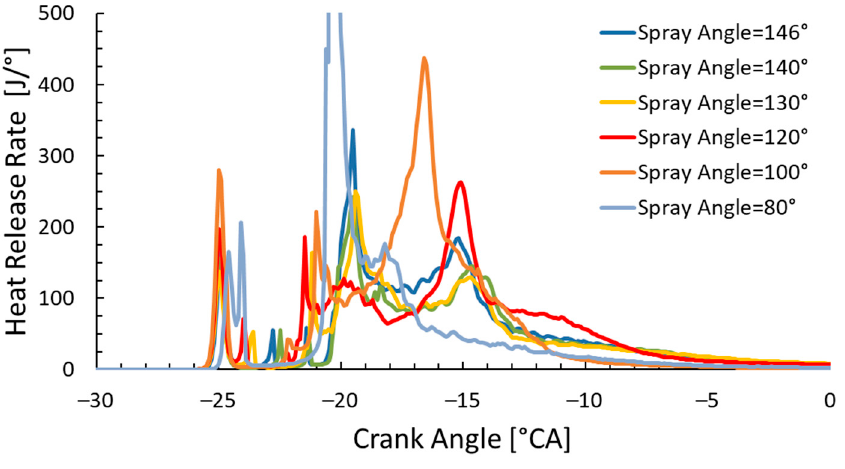
Figure 26. Effect of SIA on AHRR history for an ESI with SOI of − 50 °CA ATDC.